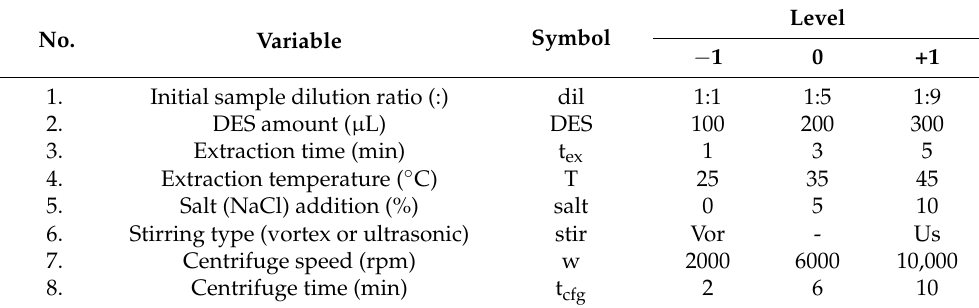
Table 1. Variables and their ranges ( − 1, 0, +1) for the Plackett–Burman screening design.